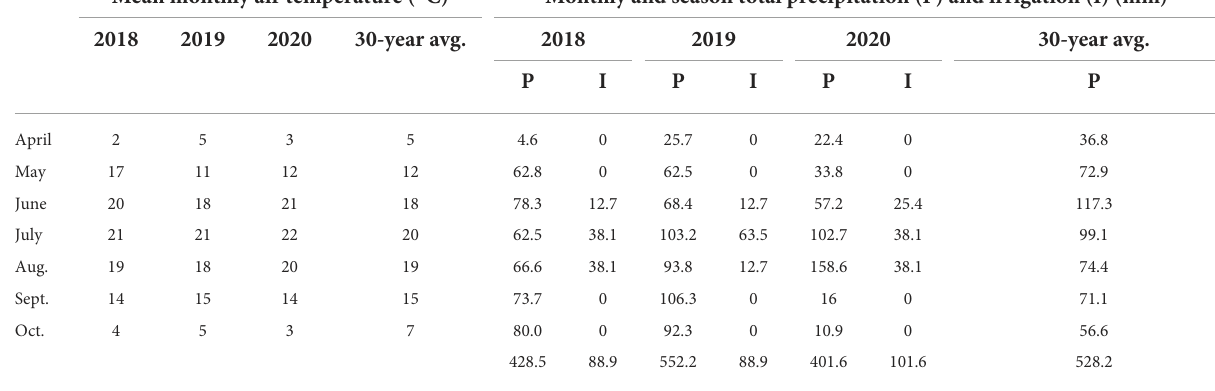
TABLE 1 Average air temperature, precipitation, irrigation, and 30-year averages for each month of the growing season in Staples, MN. ◦ Mean monthly air temperature ( C) Monthly and season total precipitation (P) and irrigation (I)